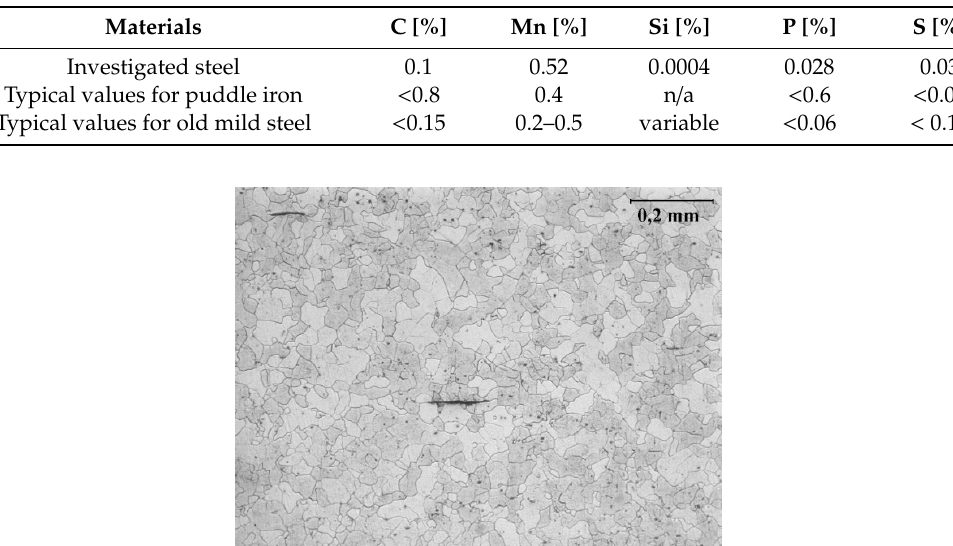
Table 1. Chemical composition of the investigated steel and typical values for puddle iron and old mild steel [18].